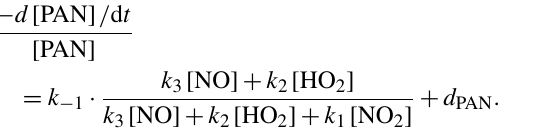
Figure 4. Lifetimes of PAN and PAA. The more regular diel cycle of PAA reflects the dominance of dry deposition with only a small contribution due to OH (visible as some fine structure in the midday loss-rate constant). PAN losses are dominated by thermal decompo- sition during the day and deposition at